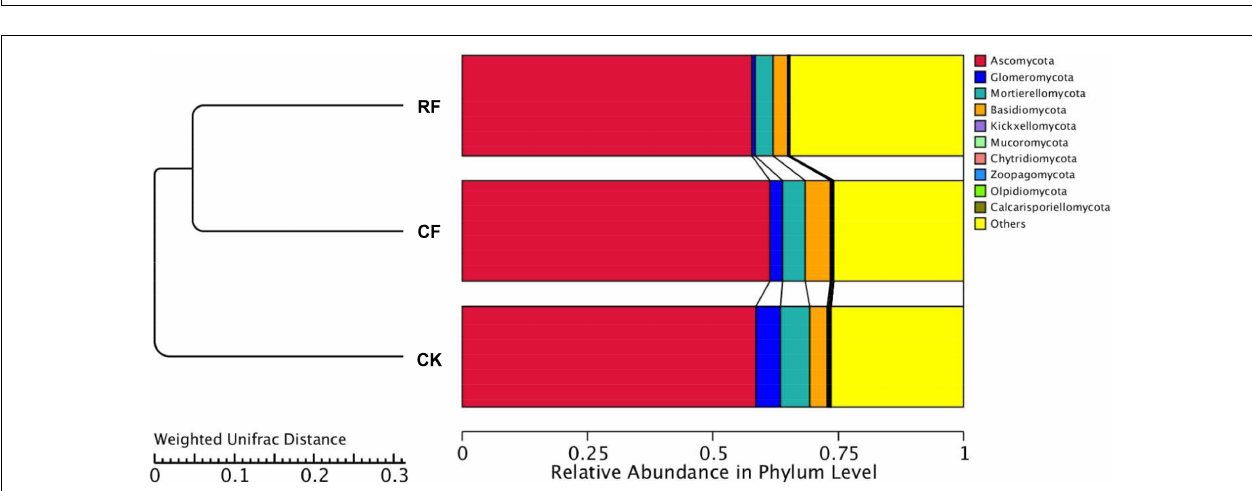
FIGURE 6 | Results of weighted unifrac cluster analysis of operational taxonomic units in the rhizospheric soil of cassava with different fertilization. CK, CF, and RF indicate without fertilizer applied, with compound fertilizer applied, and with reduced fertilizer applied, respectively.